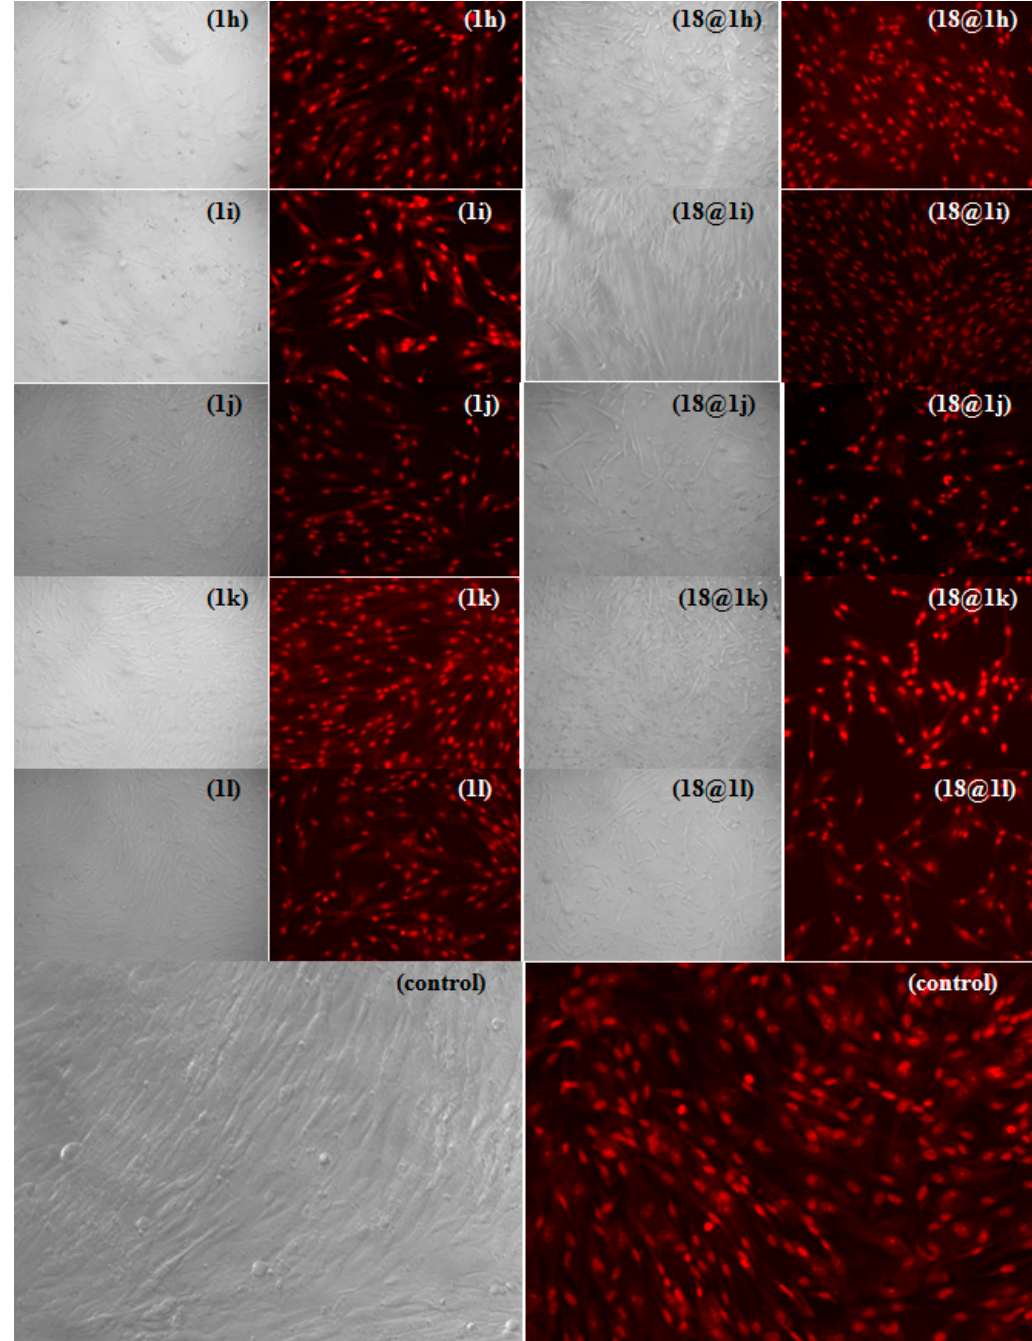
Figure 3. Black/white and fluorescence inverted microscopy images of the mesenchymal cells adhered for 24 h on: microscopic slides (control), microscopic slides coated with the bare compounds ( 1a-l ) and respectively with thiourea derivatives loaded in the same concentration in Fe 3 O 4 @C 18 nanoparticles (18@ 1a-l ) (200×).